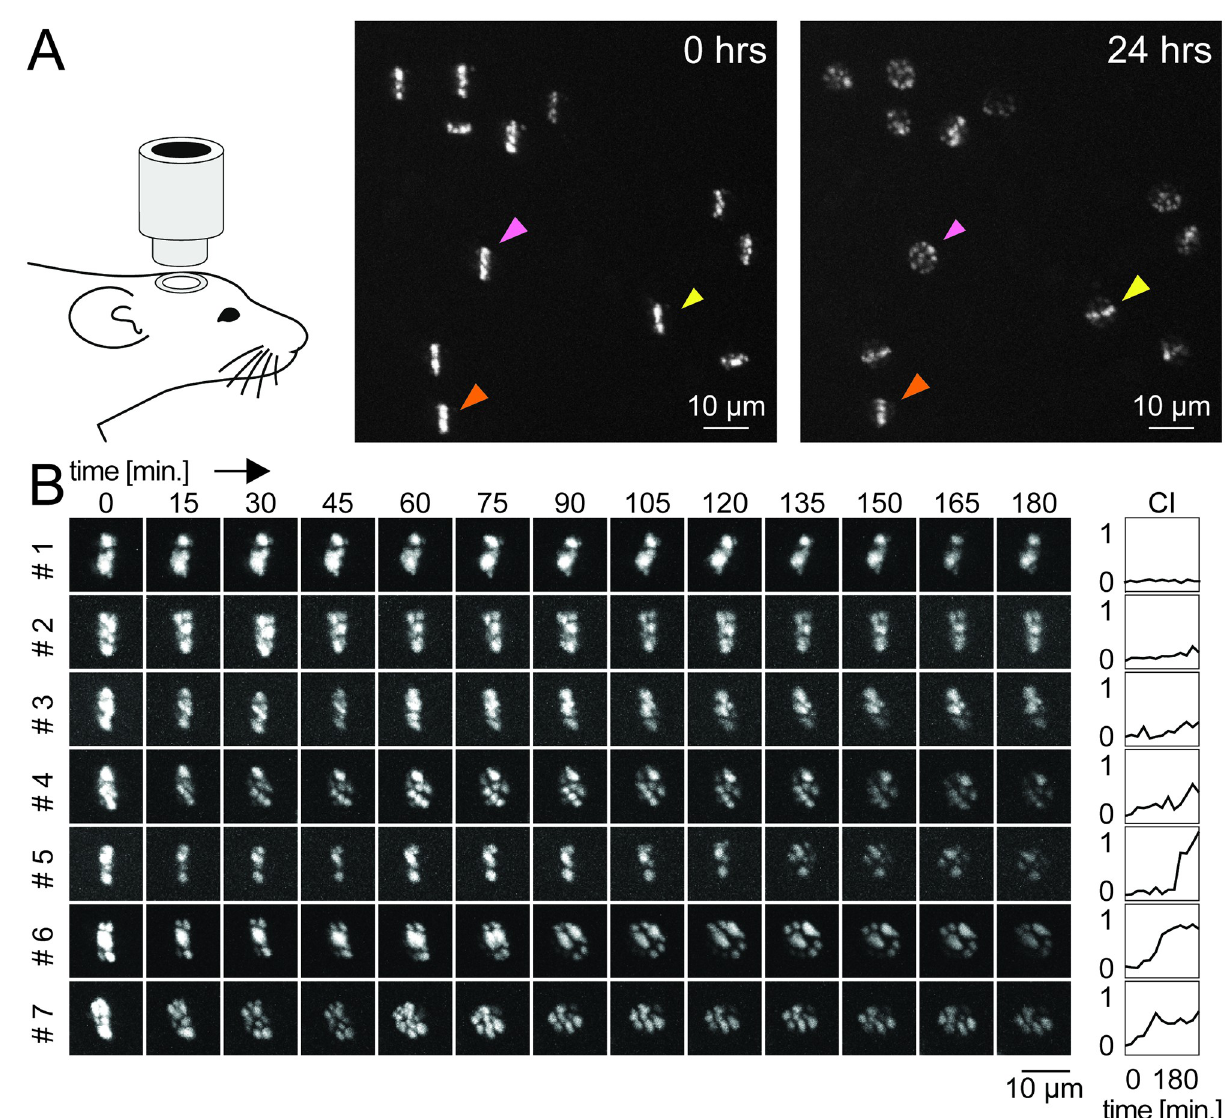
Fig 4. Nucleus-scale reorganization of chromatin in vivo . ( A ) Imaging of chromatin dynamics in vivo using a transgenic mouse line expressing H2B:: PaGFP. Two-photon images of layer II/III auditory cortex neurons photolabeled with a line across the nucleus and imaged right after labeling (0 hrs) and a day later (24 hrs). Note substantial heterogeneity in the redistribution of labeled chromatin in individual neurons. Orange arrowhead: Line pattern preserved, yellow arrowhead: Line pattern preserved but rotated, pink arrowhead: Uniform distribution of the line pattern. ( B ) Time-lapse maximum intensity projections of two-photon images taken in vivo from individual somata at a 15 min interval. Right panel: Corresponding CI quantification over time. CI remains stable over time or abruptly increases in individual neurons (e.g. #5–7).